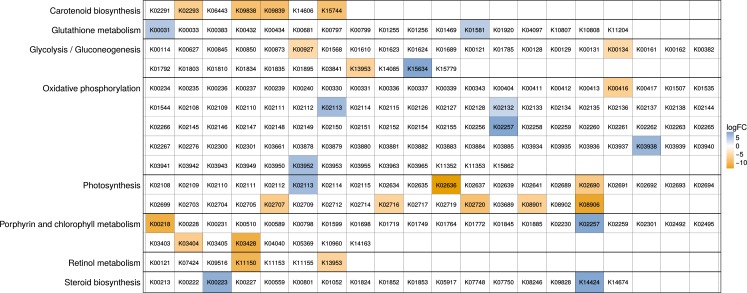
Pathways enriched for differentially expressed KOs between hetreotrophic and mixotrophic strains.Each row represents a pathway; the cells in a row represent KOs of the respective pathway. KOs showing a significant difference in expression (Benjamini–Hochberg adjusted p-value < 0.1) between trophic modes were used in a pathway enrichment analysis. For enriched pathways (p-value < 0.1), all KO IDs belonging to the pathway are shown, and significantly differential KOs are colored with their log-fold change. Yellow indicates a higher expression in the mixotrophs while blue shows a higher expression of the gene in heterotrophs.